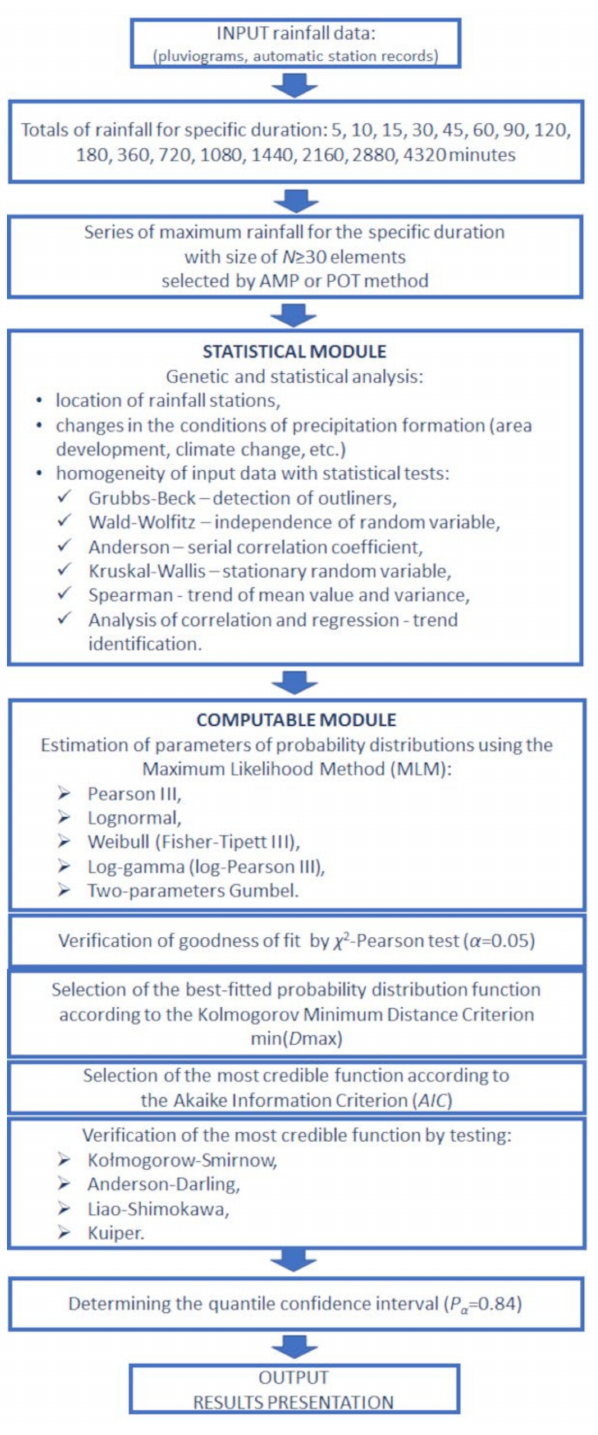
Figure 1. Overall scheme of the PMAXTP